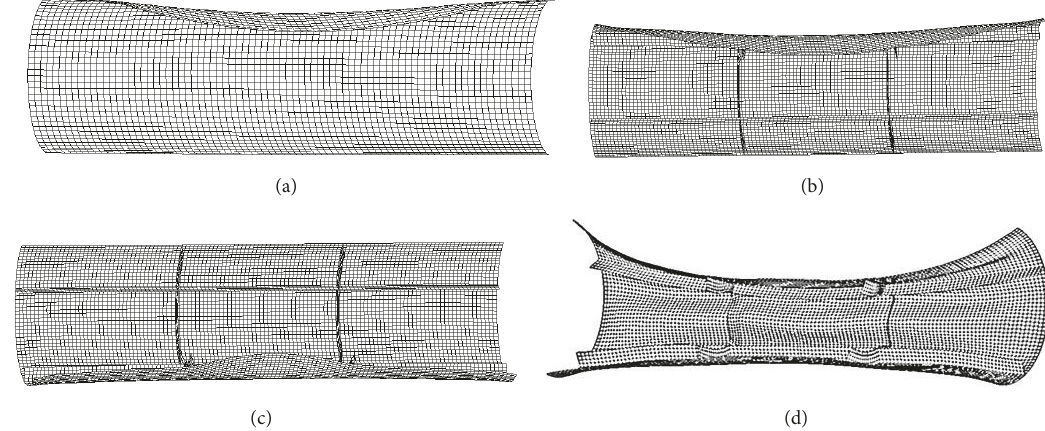
Figure 8: Deformed configuration of (a) bay buckling of unstiffened shell; (b) bay buckling of ring-stiffened cylinder; (c) local buckling of ring- and longitudinal-stiffened shell; (d) general buckling of ring- and longitudinal-stiffened shell at maximum DM. Only half of the shells are